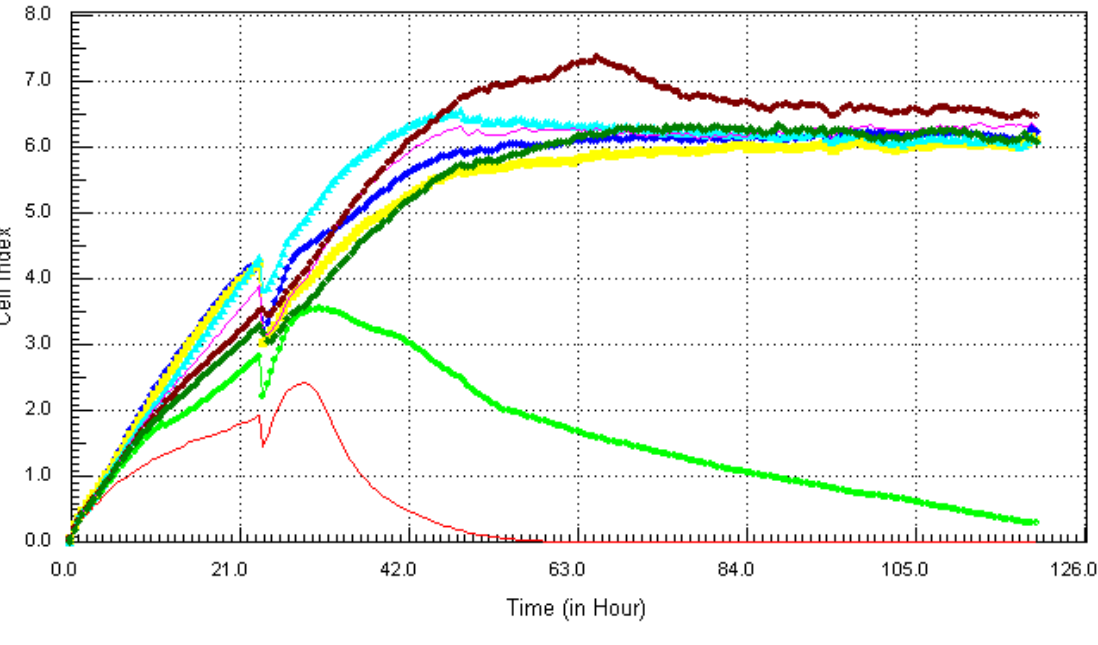
Figure 6. Kinetics of cytotoxic responses for cadmium in LBSO-treated MCF7 cells monitored by the RT-CES system. 10,000 cells/well were plated in 16-well strips for the RT-CES cytotoxicity assay. Different compound concentrations in µg/mL are indicated by different colors. Red = 21.7, light green = 10.8, blue = 5.4, yellow = 2.7, turquoise = 1.3, pink = 0.68, burgundy = 0.34, green =